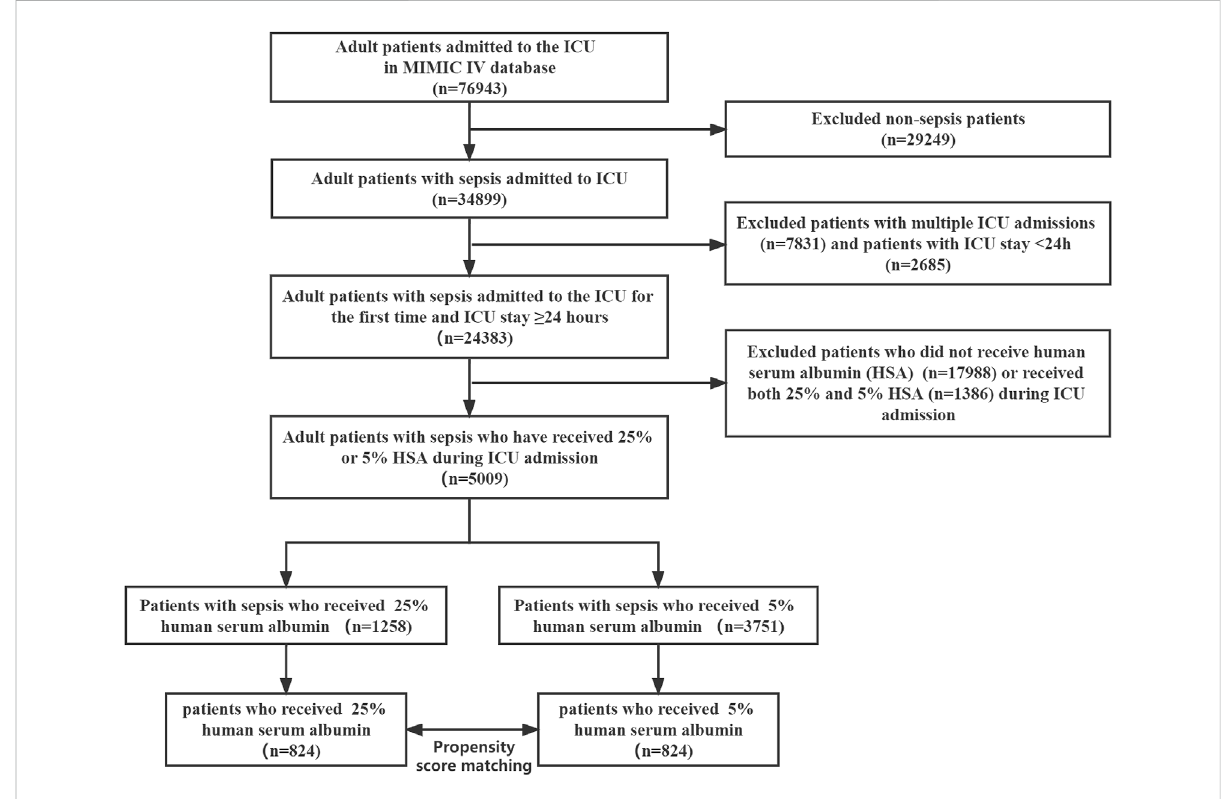
FIGURE 1 Flowchart of study patient enrollment. ICU, intensive care